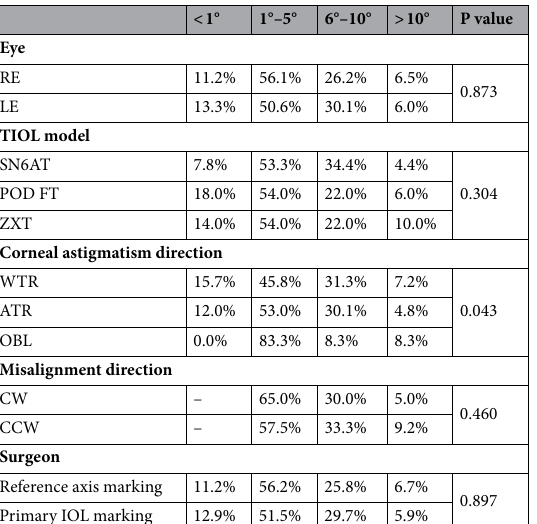
Table 4. The total deviation of the TIOL from the planned axis. RE right eye, LE eye, TIOL toric intraocular lens, CW clockwise, CCW counterclockwise, WTR with-the-rule (60°–120°), ATR against-the-rule (0°–30°,